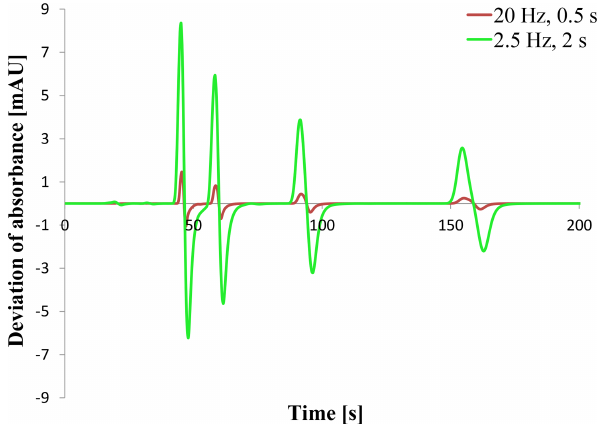
Figure 5. Signal deviation as the difference between Chromeleon ® and Second Controller Instance when using a sampling rate of 20Hz (0.5s response time) and 2.5Hz (2s response time).